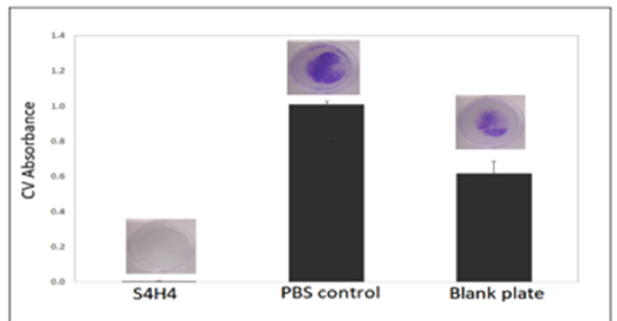
Figure 6. Crystal violet assay for biofilm formation showing that wells coated with S4H4 do not support biofilm formation, as evidenced by the lack of purple color. Alternatively, wells rinsed with PBS or the blank clearly evidenced biofilm (as indicated by optical density at 600 nm and presence of purple color). (n = 3).